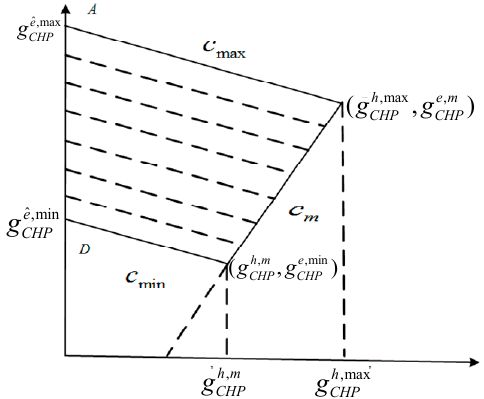
Figure 3. Electric power and heating power curve.